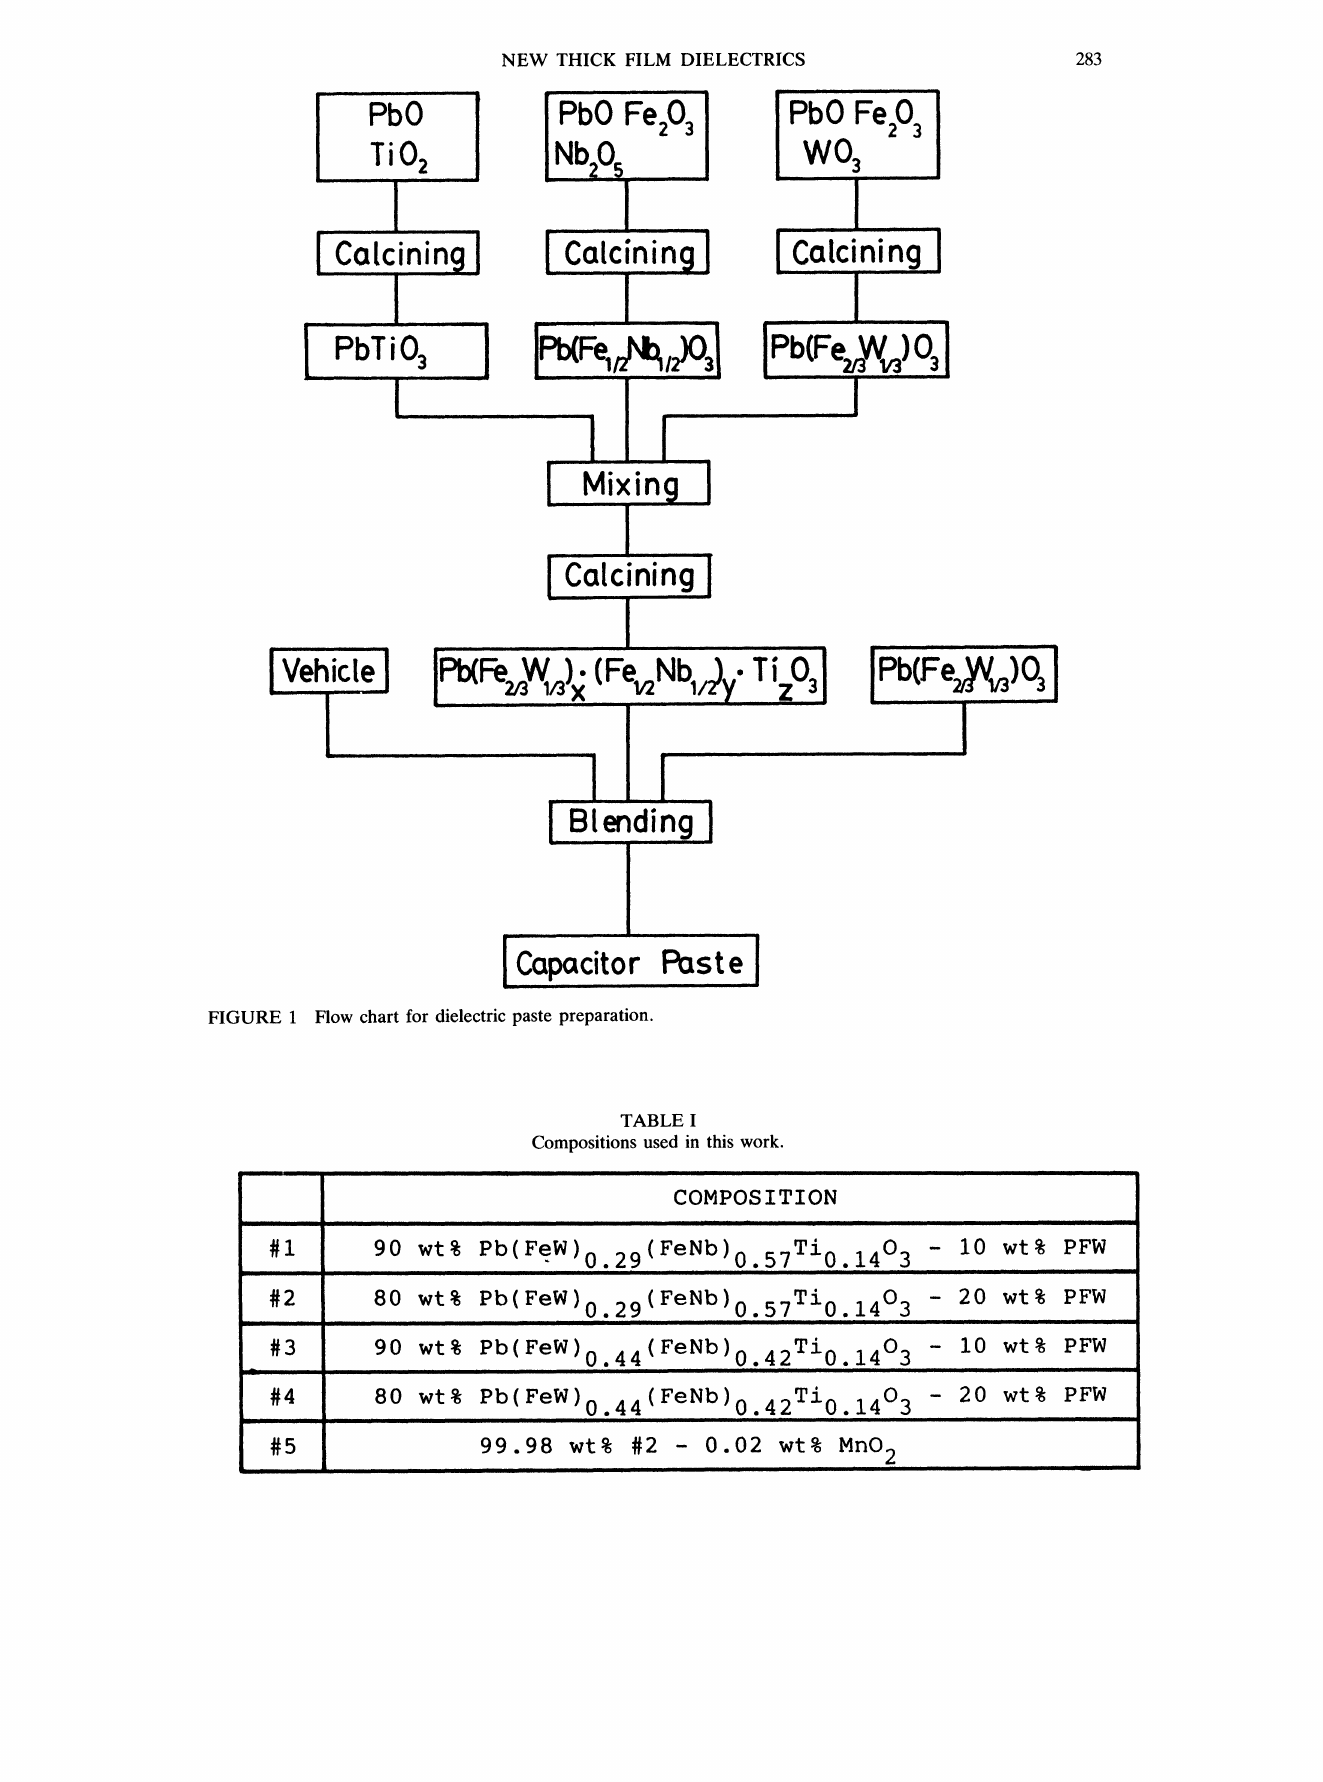
TABLE Compositions used in this